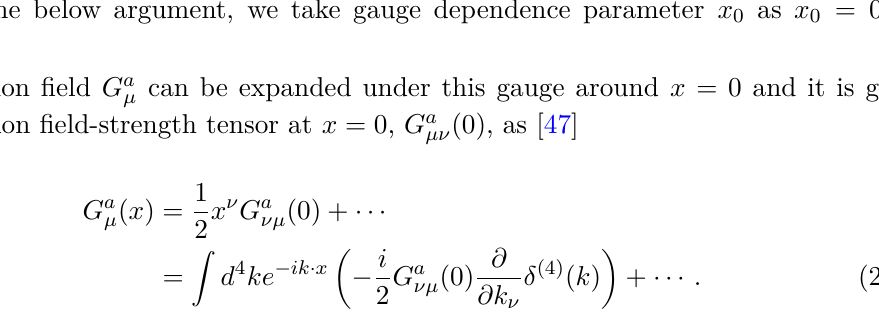
for the loop-diagrammatic evaluation of the ¯ θ parameter. X